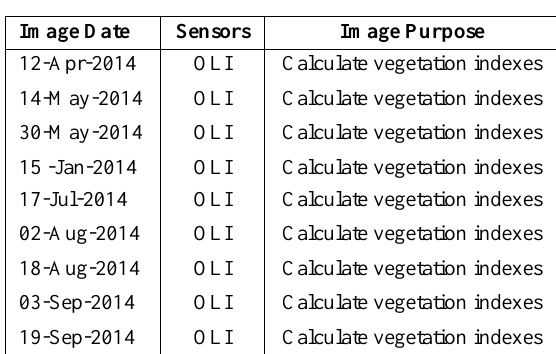
Figure 1 . The location of the study area